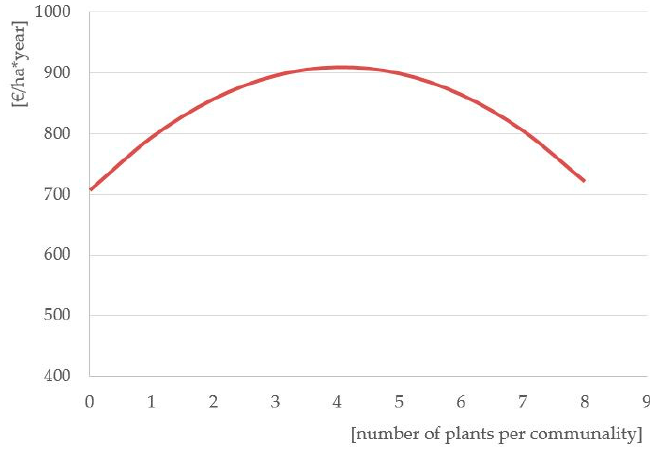
Figure 3. Function of number of biogas plants in a municipality on rental price ( pl_m ).